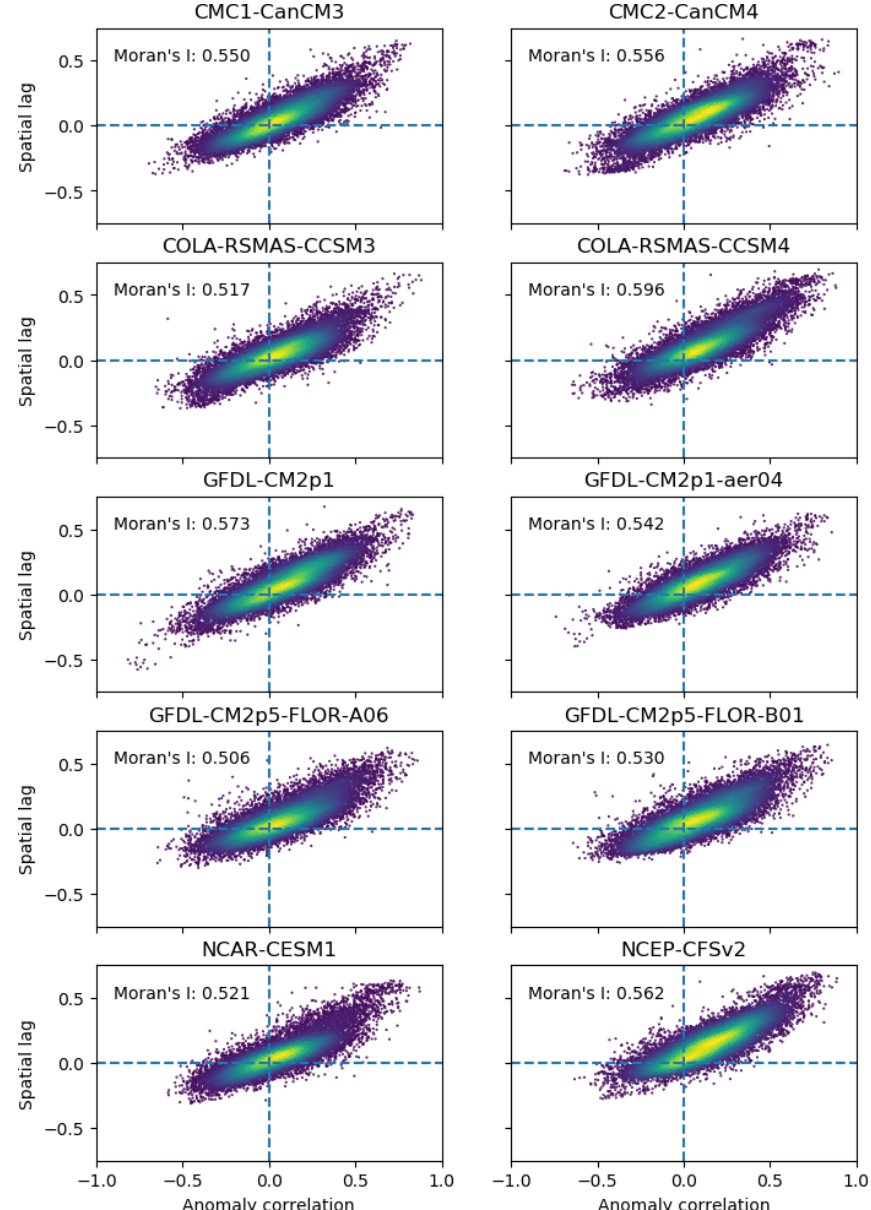
Figure 2. Scatter plots of anomaly correlation at one grid cell against the corresponding spatial lag, i.e. spatially weighted and averaged anomaly correlation at surrounding grid cells. The density of points is estimated by the kernel density function and shown by the viridis heatmap, with yellow (blue) colour indicating high (low)